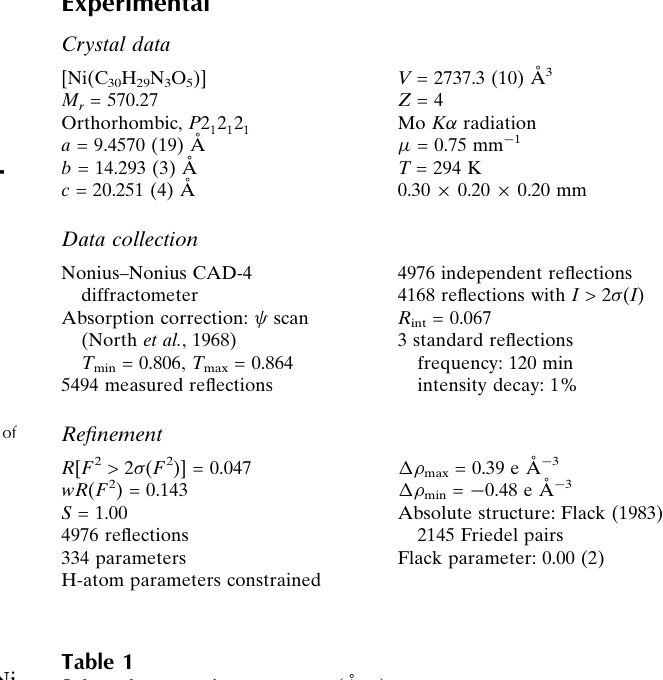
Selected geometric parameters (A˚ , (cid:2) ).